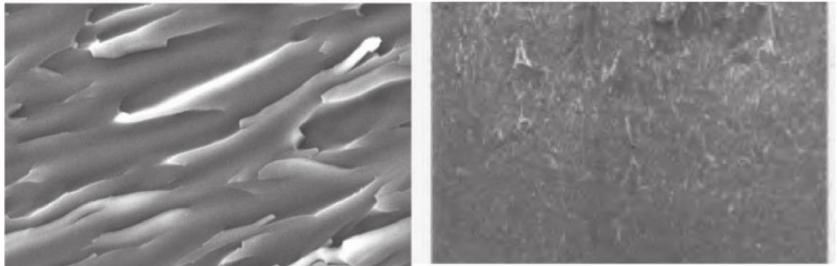
Figure 10: Microstructure of epoxy resin fracture surface [47, 48].